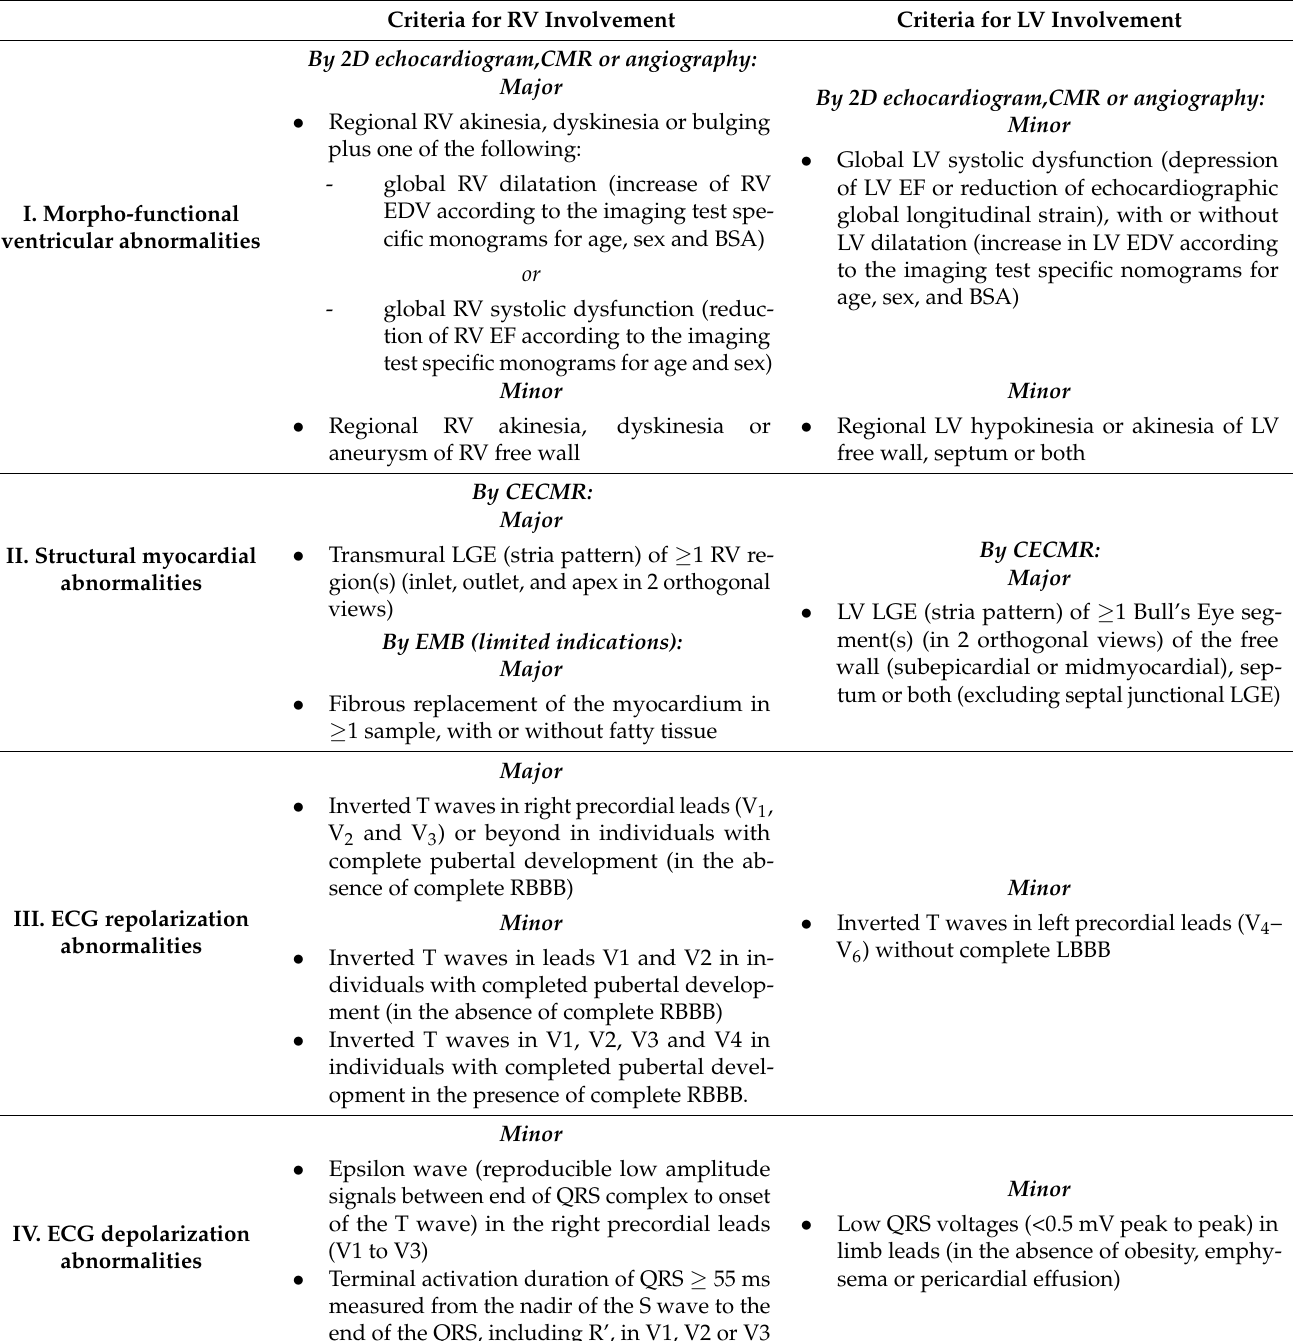
Table 1. The “Padua criteria”–ACM, arrhythmogenic cardiomyopathy; ALVC, arrhythmogenic left ventricular cardiomyopathy; BSA, body surface area; CECMR, contrast-enhanced cardiac magnetic resonance; CMR, cardiac magnetic resonance; EDV, end diastolic volume; EF, ejection fraction; EMB, endomyocardial biopsy; LBBB, left bundle branch block; LGE, late gadolinium enhancement; LV, left ventricle; RBBB, right bundle branch block; RV, right ventricle; RVOT, right ventricular outflow tract. Adapted from Corrado et al.